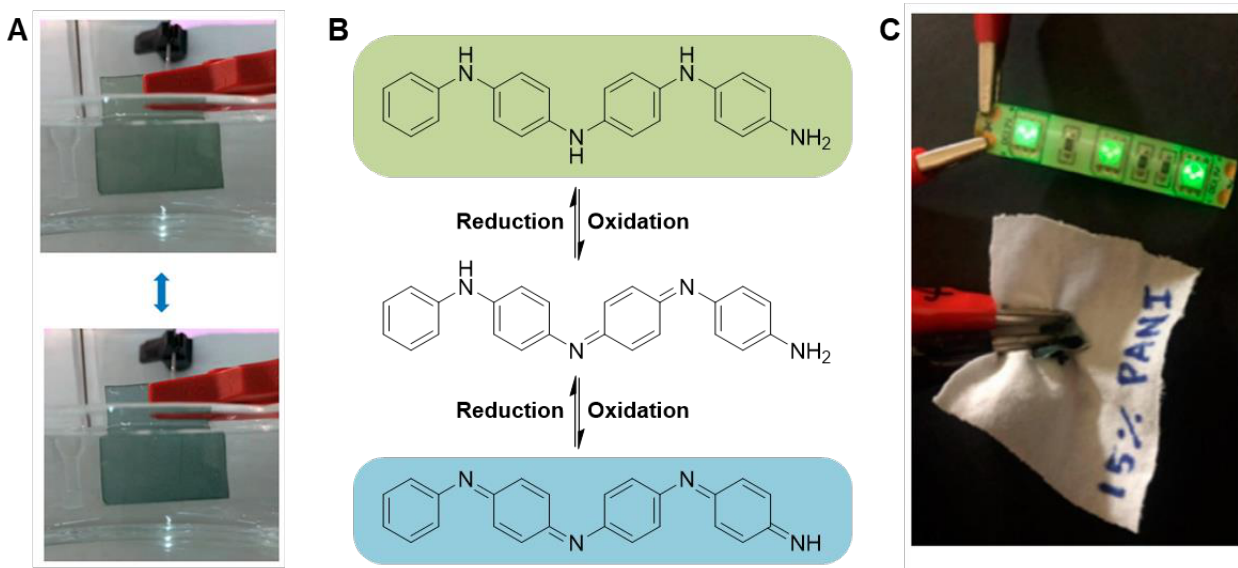
Figure 26. Electrochromic and conductive property exhibited by electrospun PANI/silk fibroin nanofibers [239]: ( A ) green coloration observed on PANI/silk fibroin after the application of 0.2 V and blue coloration observed after application of 0.6 V; ( B ) schematic of the structural and color changes accompanying the oxidation and reduction of PANI; ( C ) the same PANI/silk fibroin nanofibers sewn onto cotton fabric and used as a conductor to light up LEDs. Reprinted with Ref. [239], available at https://doi.org/10.3390/polym12092102, accessed on 1 December 2022